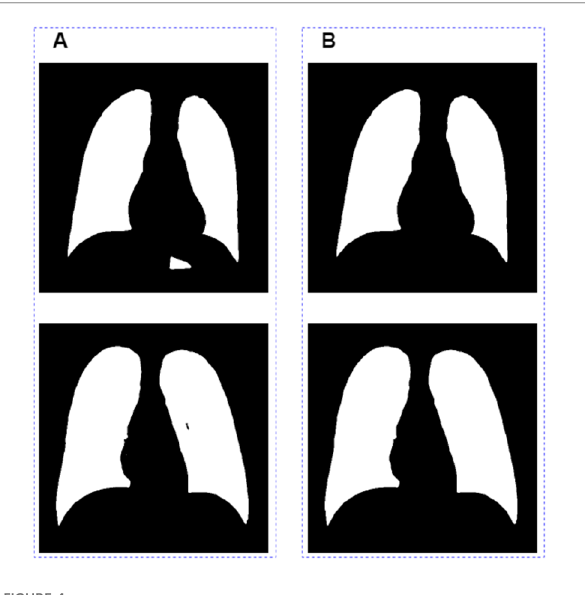
FIGURE 4 Image post-processing results. ( A ) Images before grayscale truncate. ( B ) Images after grayscale